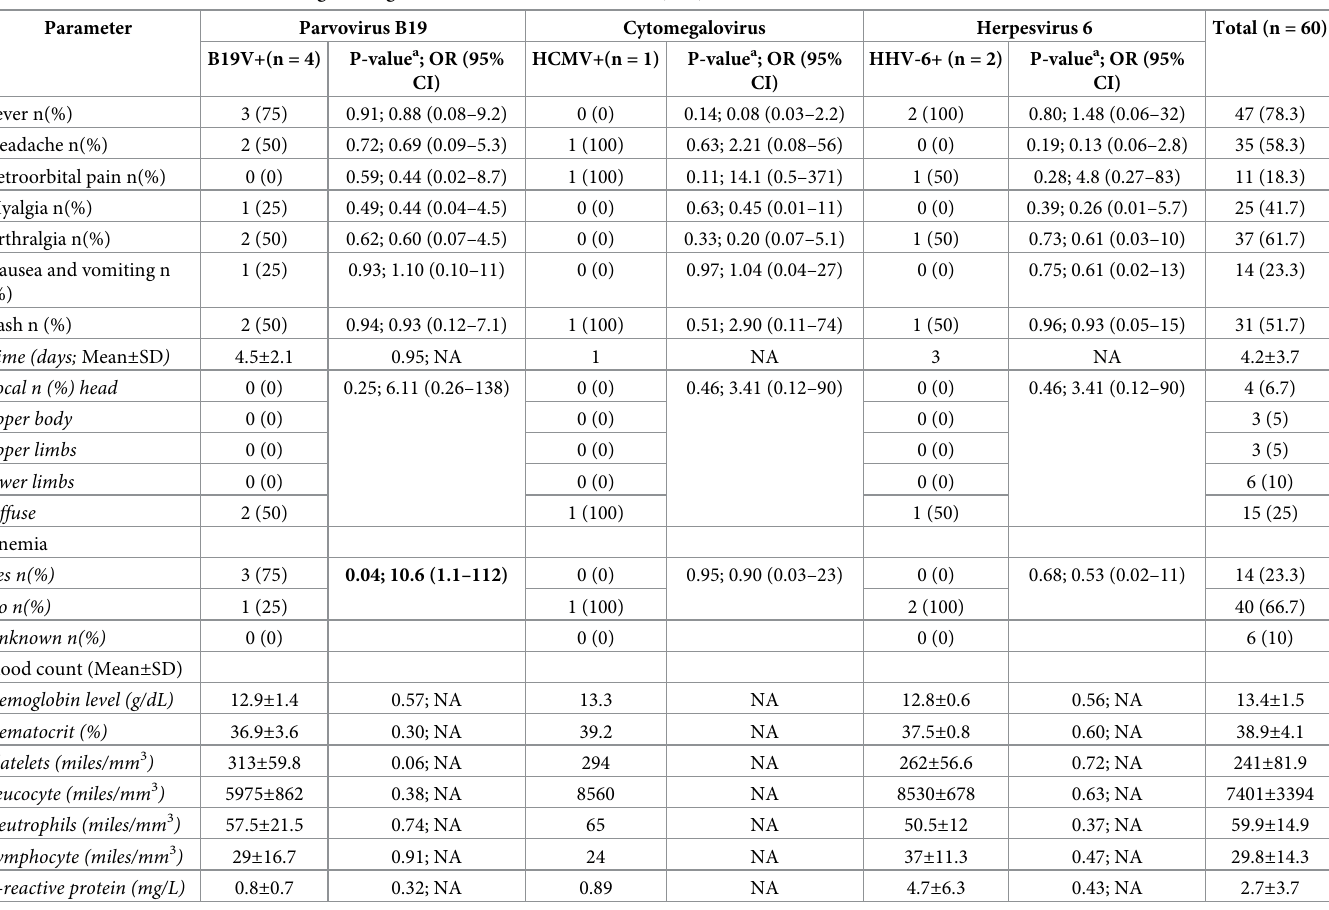
Table 6. Clinical and laboratorial findings among adults with acute febrile illness